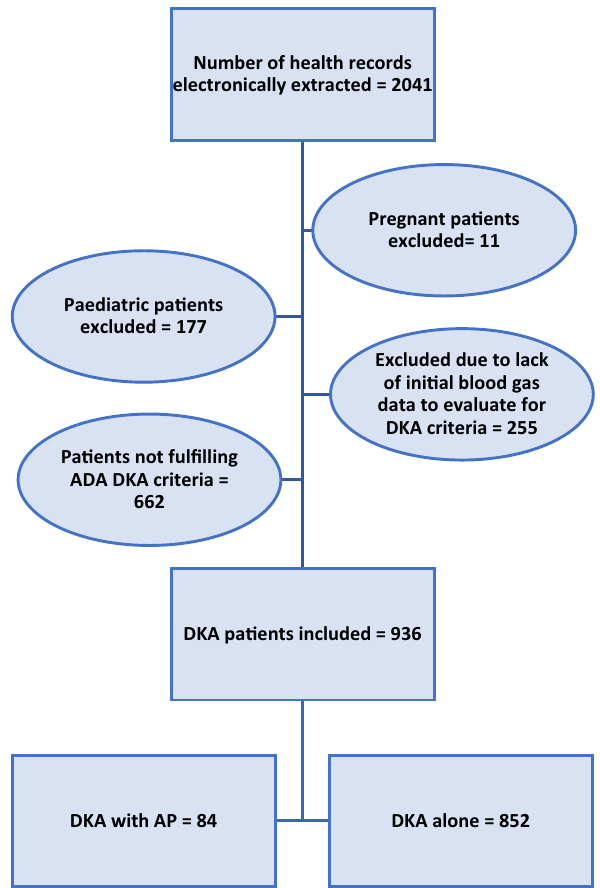
Figure 1. Flowchart of the process of inclusion of patients in the